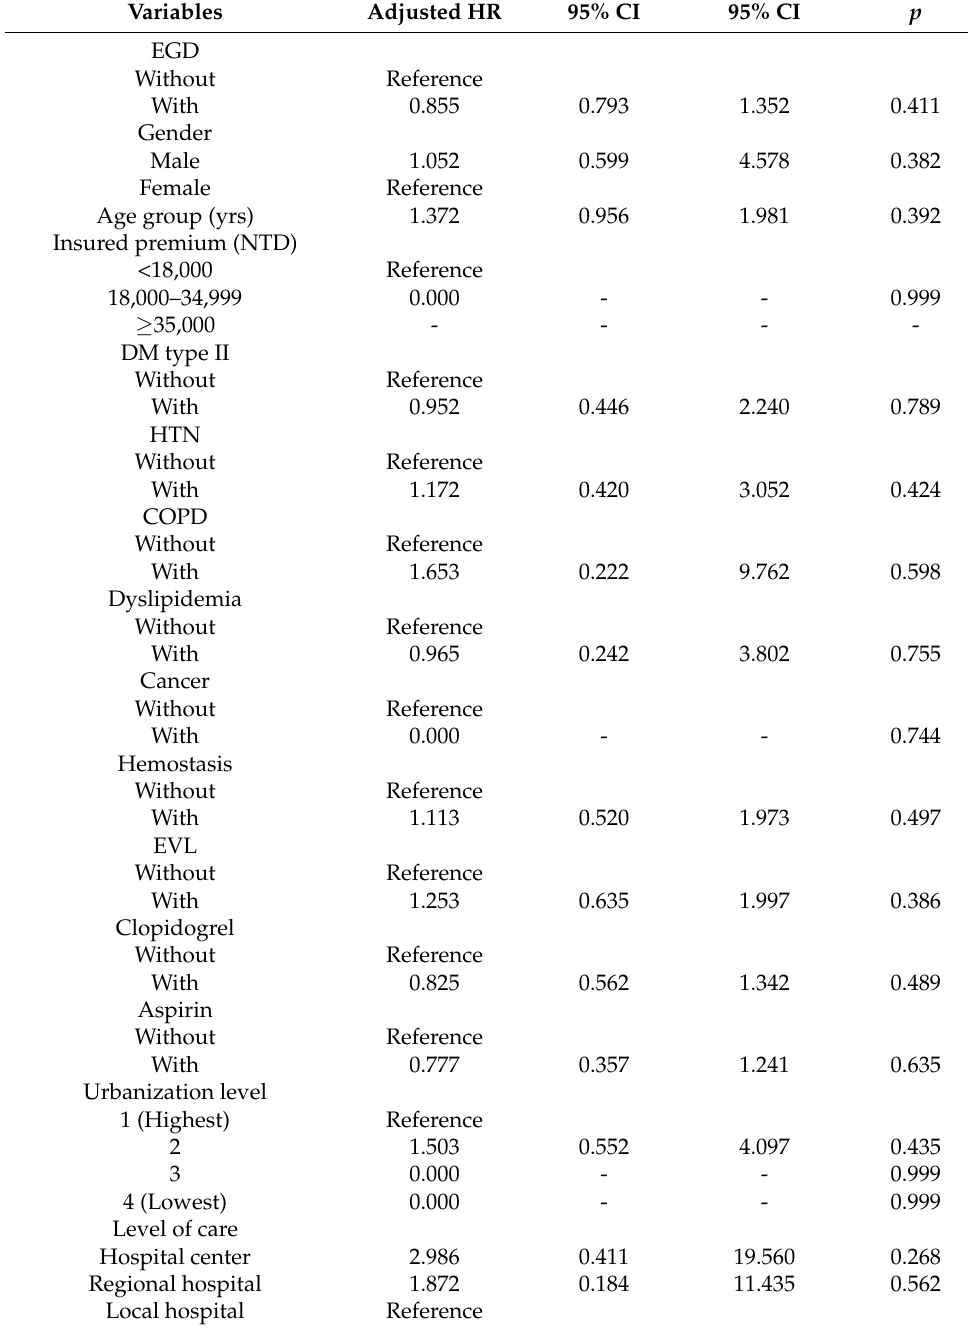
Table 2. Factors of CAD recurrence in one month by using multivariable Cox